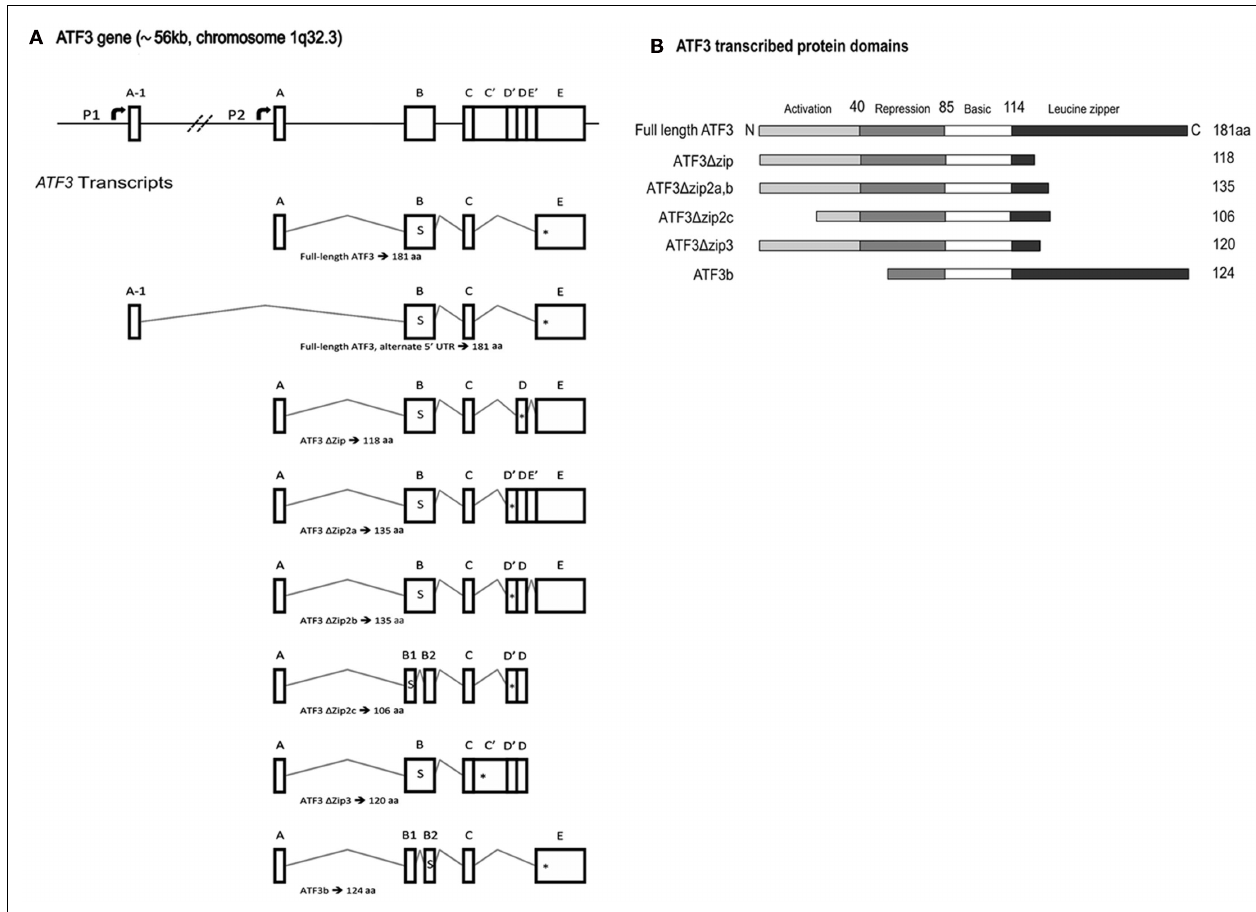
FIGURE 2 |Activating transcription factor 3 (ATF3) gene and protein structure. (A) A schematic representation of ATF3 gene structure and transcript splice variants.The human ATF3 gene spans approximately 56kb on chromosome 1q32.3, and comprises six exons.This schematic adopts